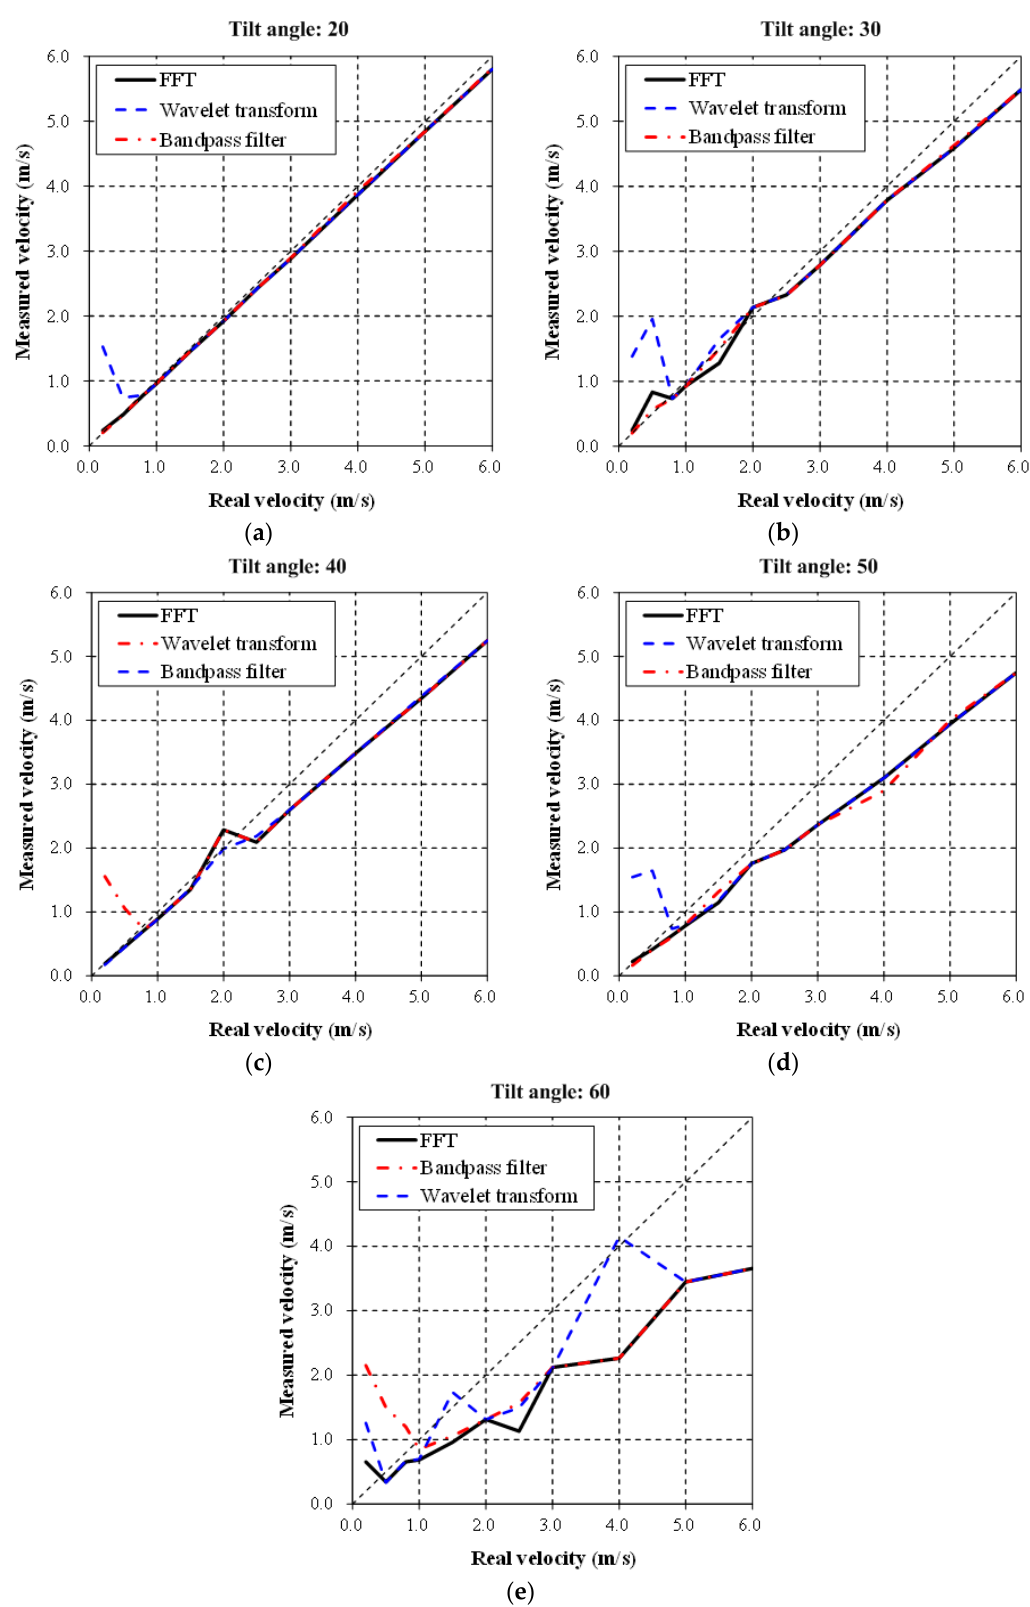
Figure 9. Comparison of the results of the flow velocity experimental analysis using the FFT, bandpass filter, and the wavelet transform. ( a ) Tilt angle = 20°; ( b ) Tilt angle = 30°; ( c ) Tilt angle = 40°; ( d ) Tilt angle = 50°; ( e ) Tilt angle = 60°.